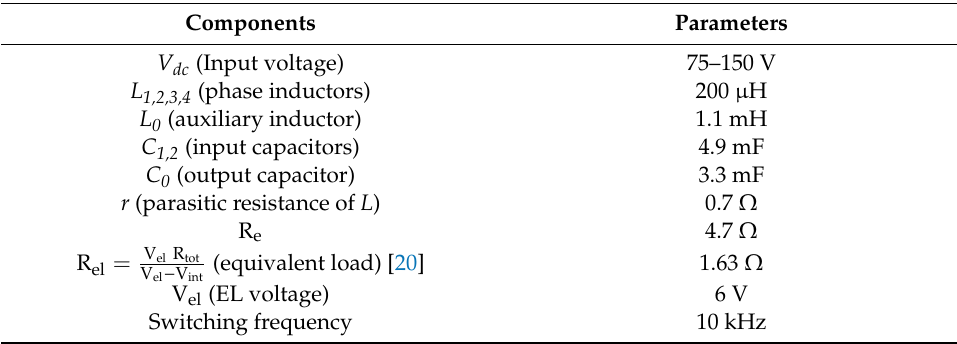
Figure 6. diagram of the uncompensated system according to the input DC voltage V dc. Table 3. System specifications.